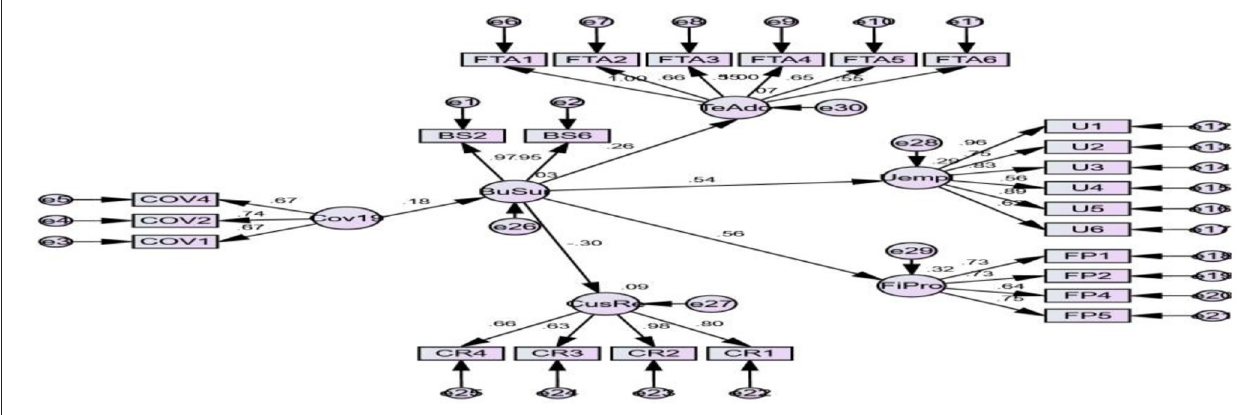
FIGURE 1 | Standardized hypothesized structural equation